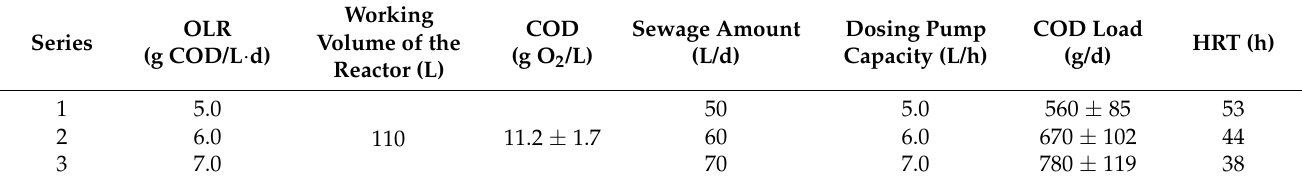
Table 4. Study organization and exploitation parameters in stage